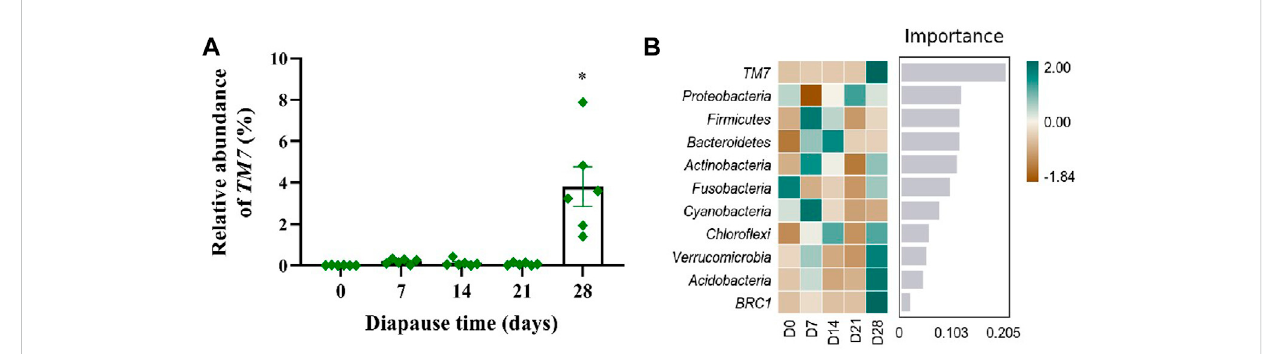
FIGURE 5 Effectofdiapausetimeonmarkerspeciesofgutmicrobiotain C.bilineatatsingtauica larvae.Therelativeabundanceof TM7 (A) alteredwithdiapause